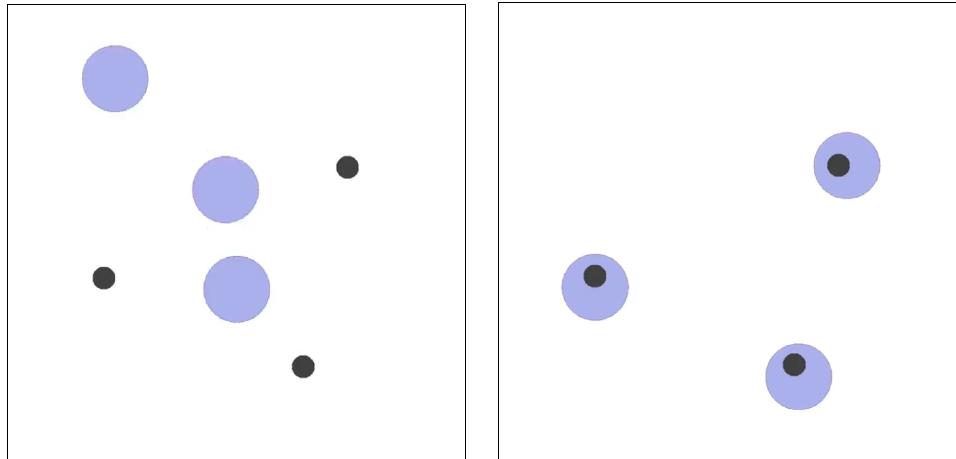
Figure 1. Cooperative navigation task. Large purple circles are agents; small black circles are landmarks. The reward scheme incentivizes the coverage of each landmark by a different agent without collisions. ( Left ): Initial layout, agents and landmarks are positioned randomly. ( Right ): Final result; each landmark is covered by one